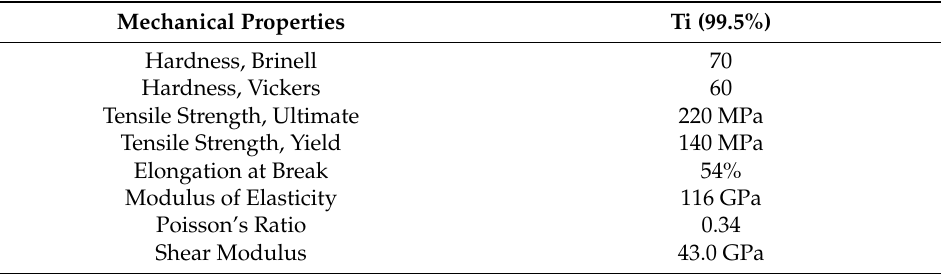
Table 1. Mechanical properties of pure titanium.